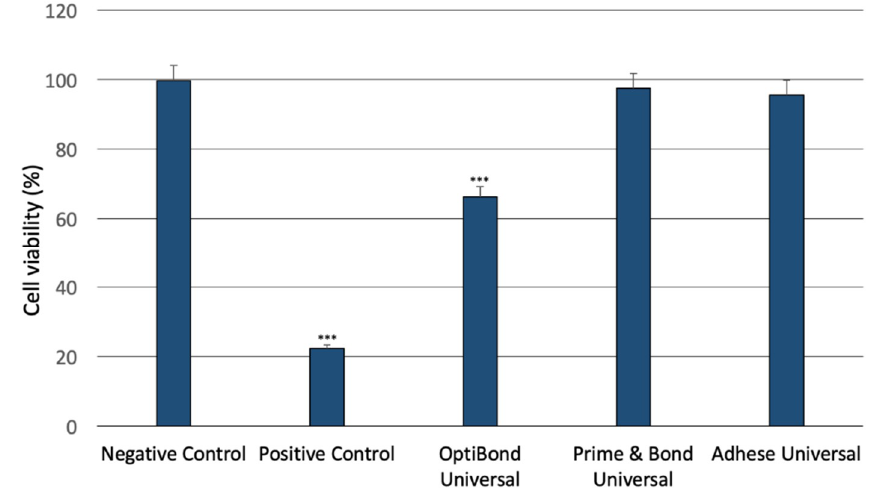
Figure 1. Cytotoxicity of the investigated adhesives. *** p < 0.001 versus negative control.